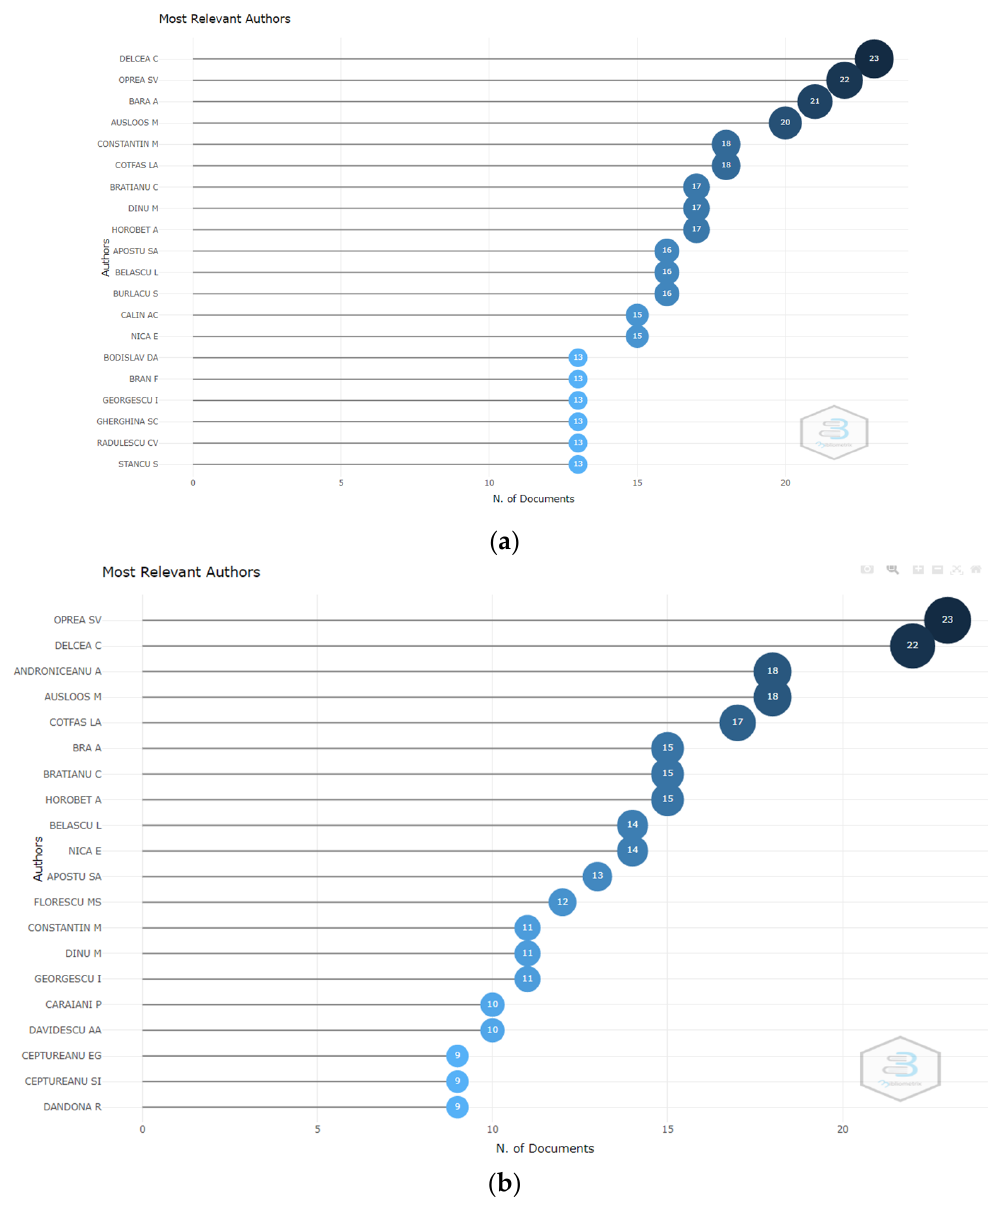
Figure 5. Most relevant authors by the number of documents. ( a ) WoS. ( b ) Scopus.